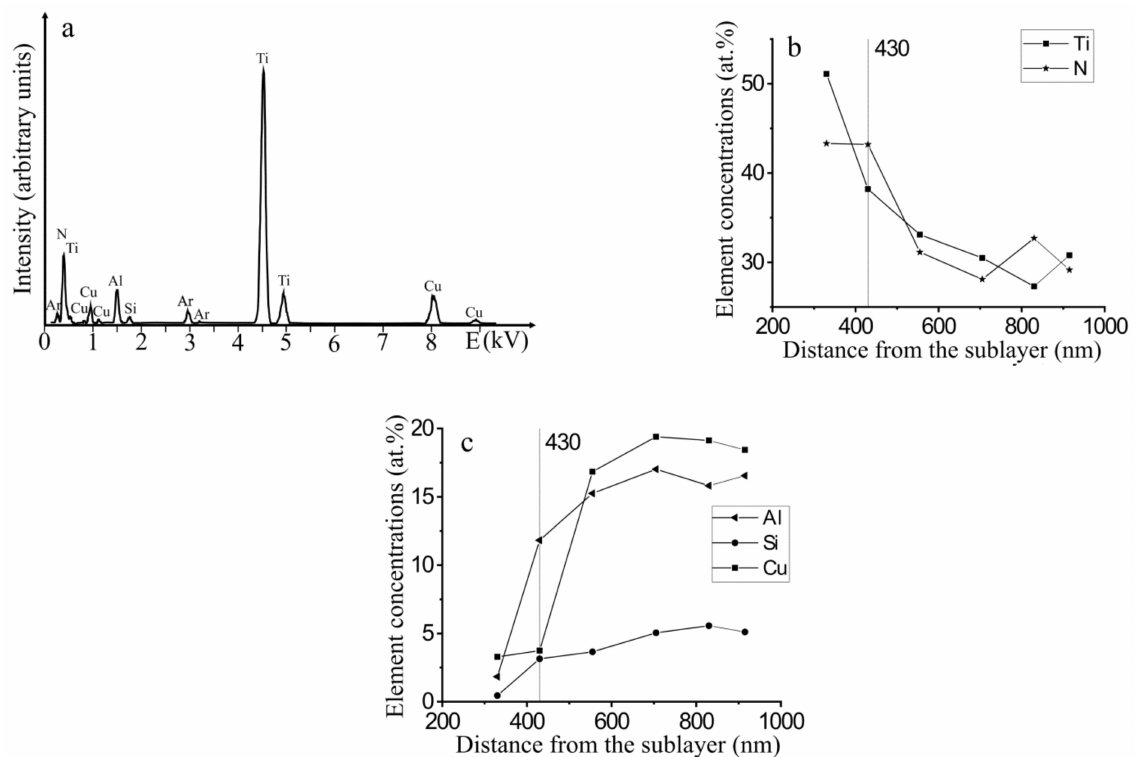
Figure 3. The elemental composition of the gradient-laminated Ti-Al-Si-Cu-N coating. ( a ) Character- istic X-ray spectrum at a point near the interface between the nanocrystalline and columnar layers; ( b , c ) plots of element concentration in the coating vs. distance from the α -Ti